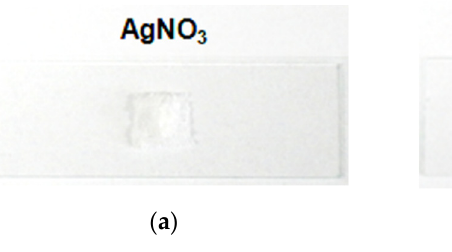
Table 5. Values of the lattice parameters of silver nitrate (AgNO 3 ), silver oxide (Ag 2 O), and silver (Ag).